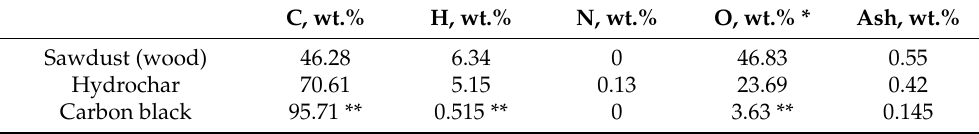
Table 4. Elemental ** and ash analysis of sawdust (from hardwood), hydrochar, and carbon black. C, wt.% H, wt.% N, wt.% O, wt.% * Ash, wt.% Sawdust (wood) 46.28 Hydrochar 70.61 Carbon